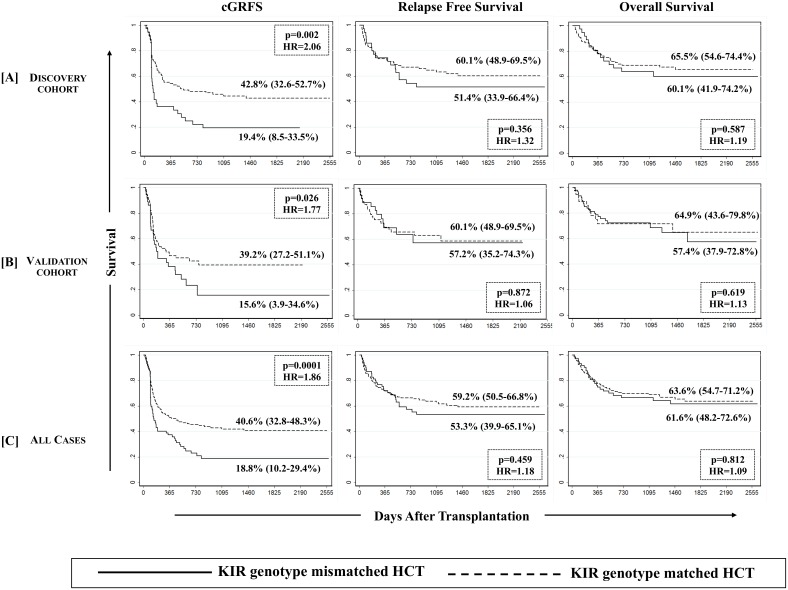
Effect of KIR genotype matching on the survival outcomes.Estimates of cGVHD & relapse free survival (cGRFS, left panel), relapse-free survival (RFS, middle panel) and overall survival (OS, right panel) are presented across discovery [A], validation [B] and combined [C] cohorts. A multivariate Cox Proportional Hazards Regression at the end of follow-up revealed a significantly poorer (p-values <0.05) cGRFS in both discovery and validation cohorts in addition to a combined cohort (discovery + validation) when KIR genotype mismatched donors were used.